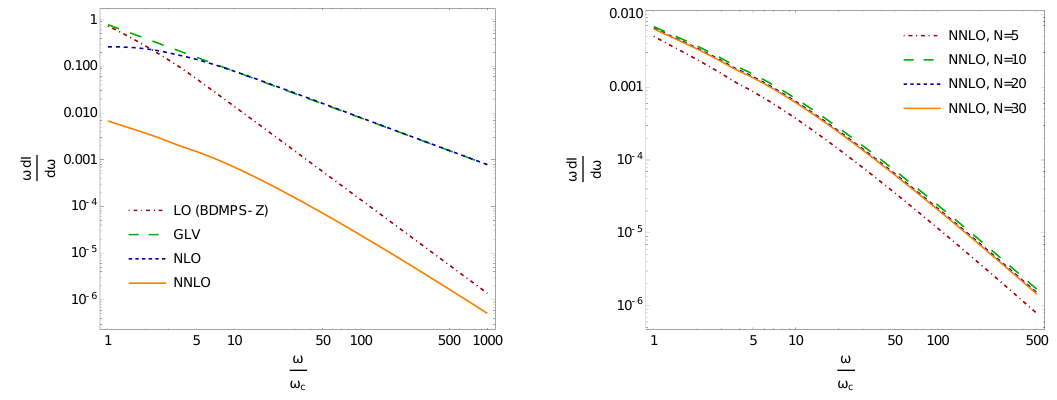
Figure 2 . Left: The di(cid:11)erent contributions to the improved opacity expansion spectrum (LO, NLO and NNLO) and the GLV spectrum, in the high frequency regime ( ! & ! c ). The plotted curves are given with the overall constant (cid:22) (cid:11) = 1. We use the following set of numerical parameters: ^ q 0 = 0 : 1 GeV 3 , (cid:22) ? = 0 : 2 GeV and L = 6 fm. This set of parameters is used for the rest of the numerical results, unless otherwise stated. Right: The NNLO term computed using equation (3.6), while replacing the upper limit of the sum by N= 5, N= 10, N= 20 and N=30. The plots that follow in the rest of this paper use N= 10, since it shows an extremely good convergence and small computational